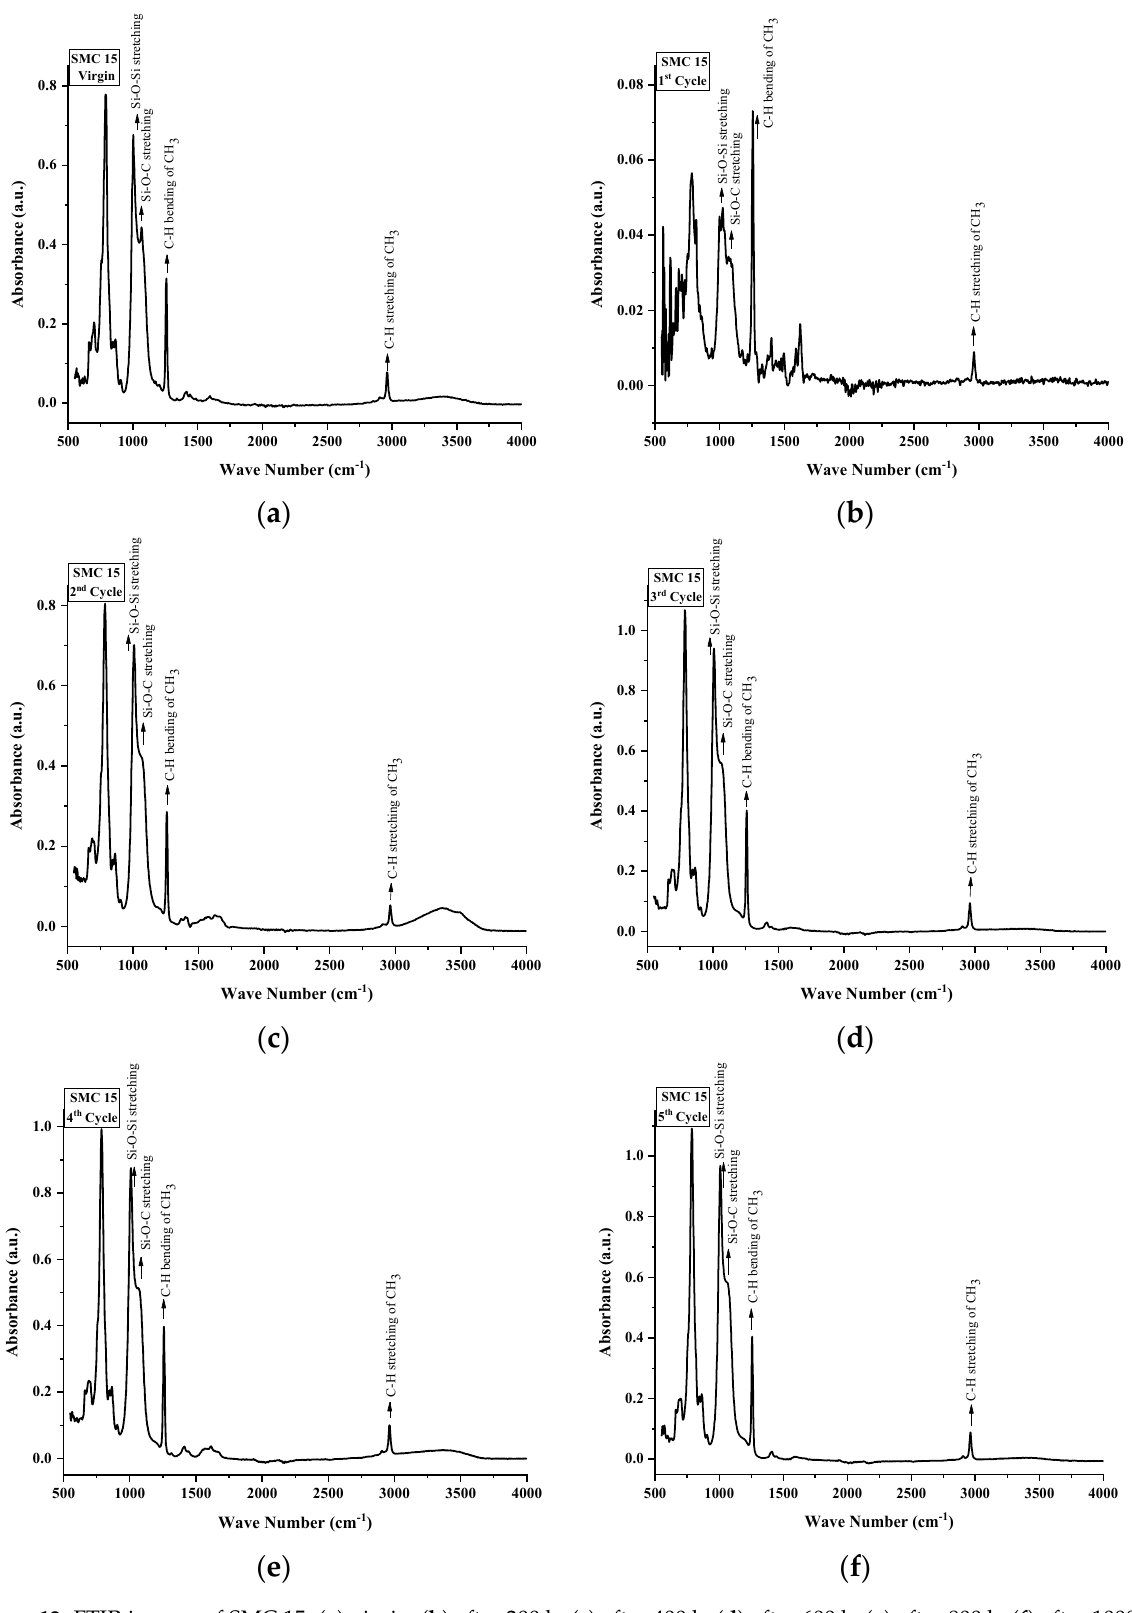
Figure 13 FTIR images of SMC 15: ( a ) virgin; ( b ) after 200 h. ( c ) after 400 h; ( d ) after 600 h; ( e ) after 800 h; ( f ) after 1000 h.